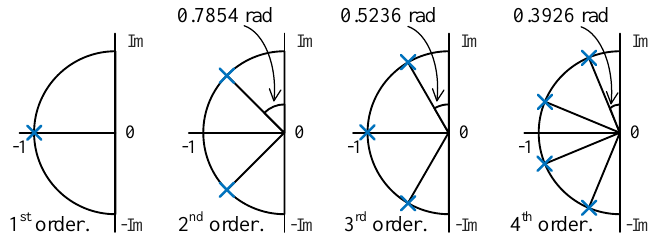
Figure 5. Butterworth root locus.